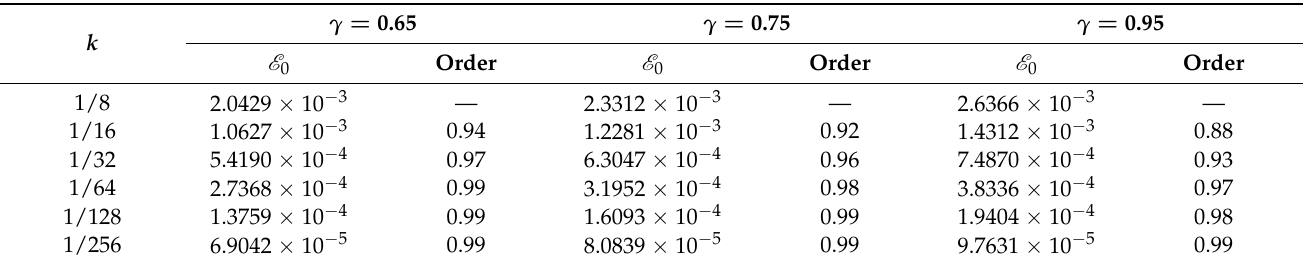
Table 6. E M and numerical convergence order in the temporal direction ( h = 1/300). 0